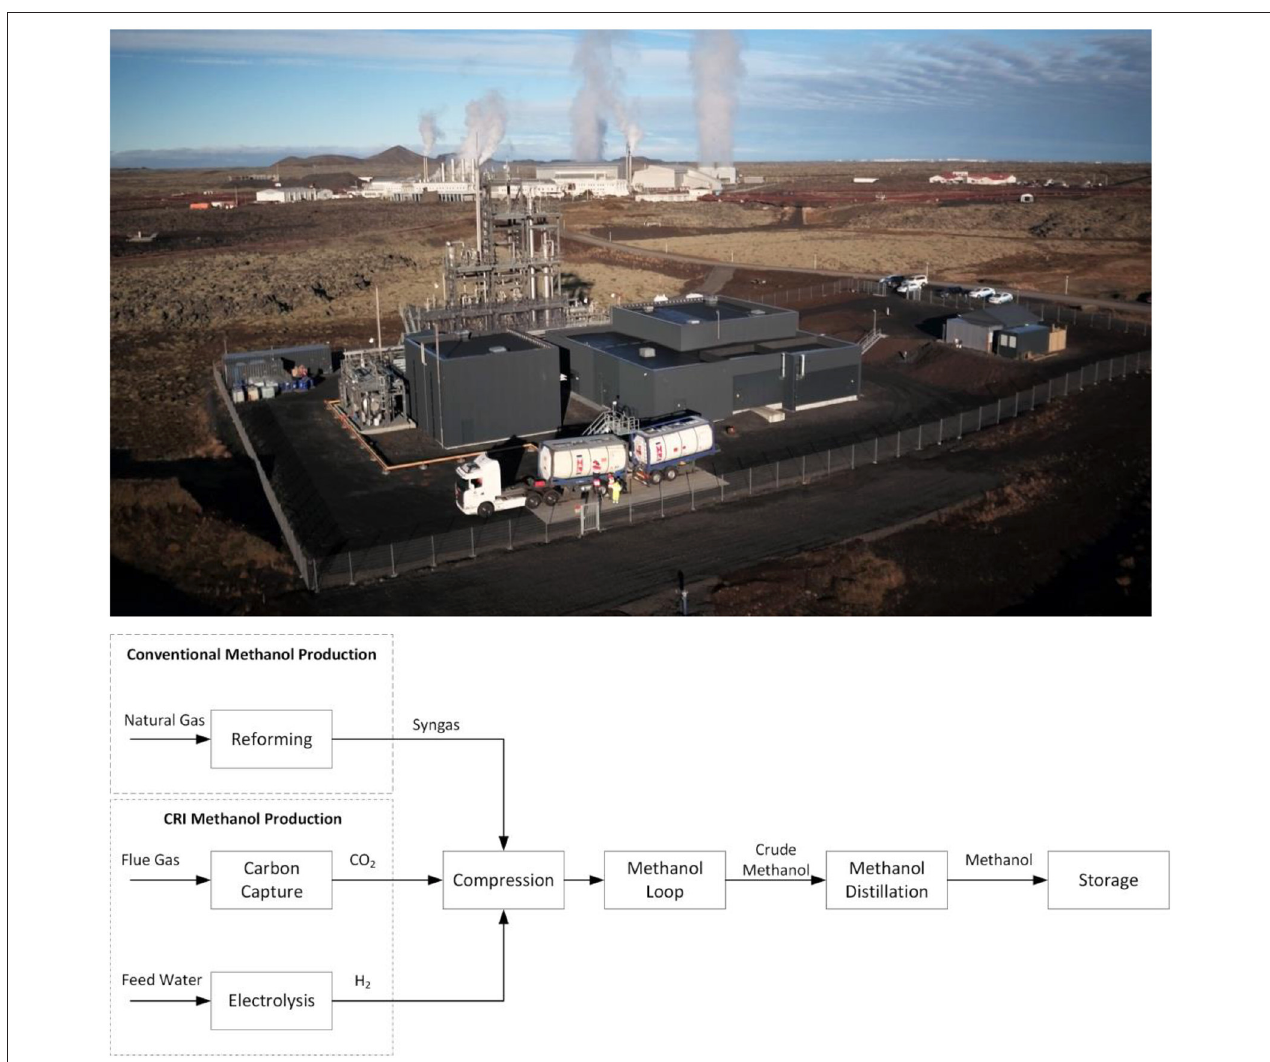
FIGURE 1 | (Top) CRI’s George Olah Renewable Methanol plant in Svartsengi, Iceland. (Bottom) Block flow diagram showing the different origins of syngas for the conventional process compared to the CRI process starting from CO 2 pointing out the energy intensive reforming process in the former.